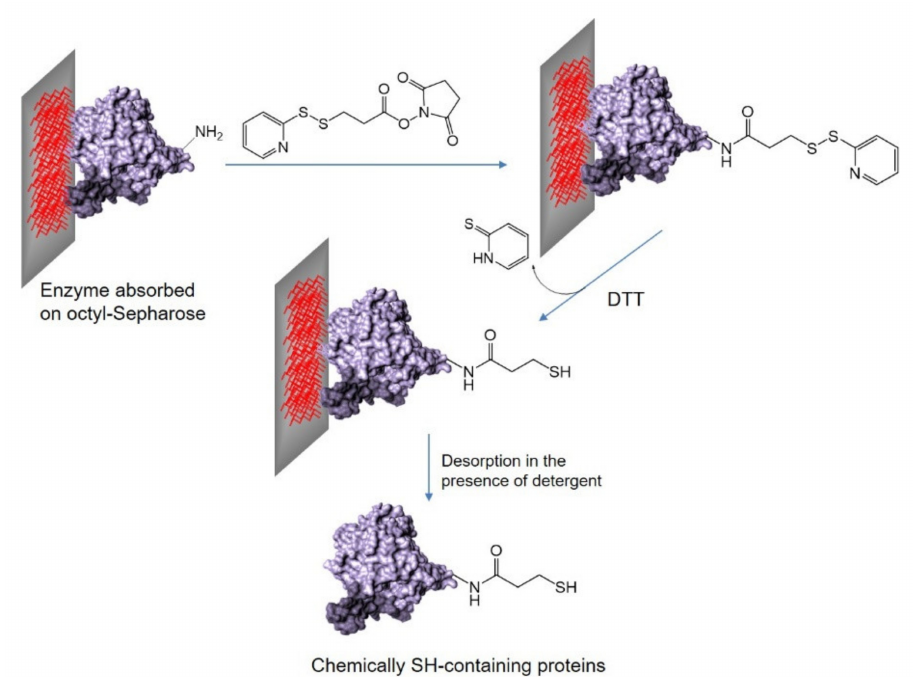
Figure 4. Scheme of the strategy for the chemical introduction of SH groups on the protein surface. (NH 2 is referred to the N -terminal amino). DTT: dithiothreitol.